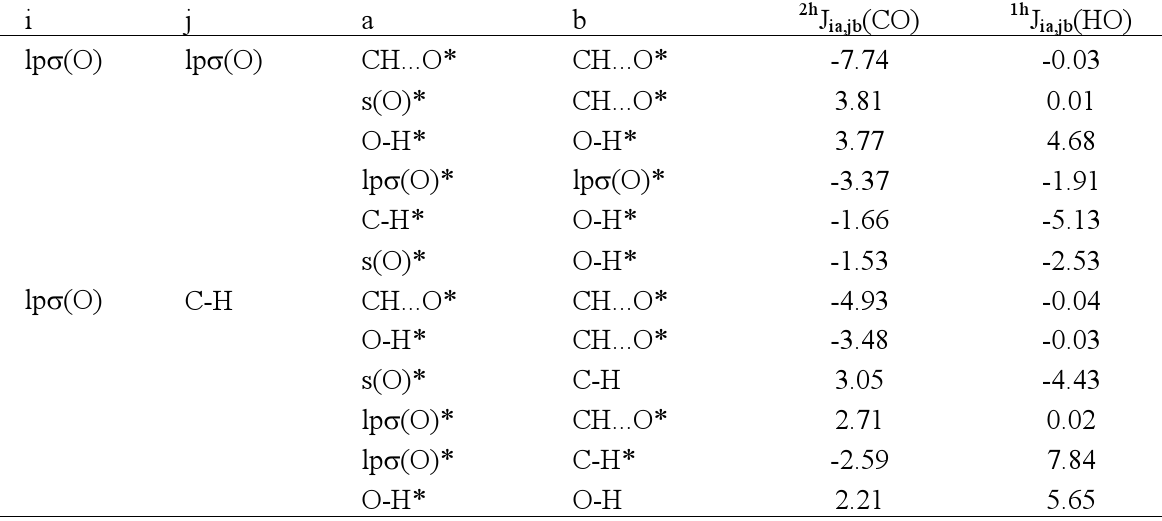
Table 3. Main “coupling pathways” J involving the C-H and lp σ (O) occupied LMOs and vacant ia,jb LMOs within the local fragment C-H...O in system I. Values in